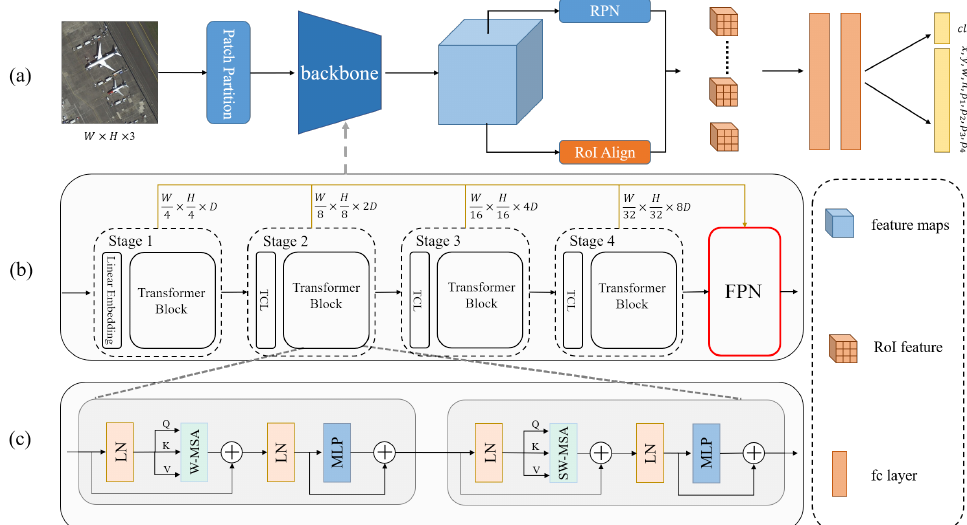
Figure 3. Overview of the proposed method. ( a ) Main structure of rotating object detection. ( b ) Main structure of Transformer model backbone. The brown arrows represent the features at each scale in the FPN. ( c ) Structure of the transformer block for feature extraction, where LN represents layer norm operations, W-MSA represents self-attention operations in the rule window, and SW-MAS represents self-attention operations in the offset window.